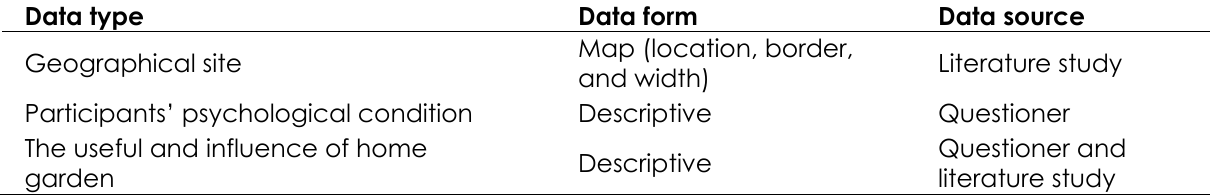
Table 1. Types, forms, and sources of study